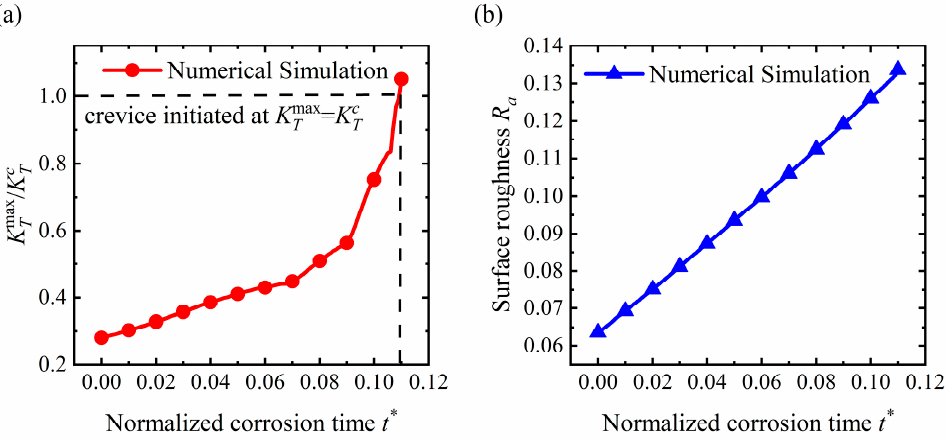
Figure 9. Evolution of ( a ) the maximal stress concentration factor and ( b ) surface roughness during corrosion when A ∗ = 0.1 and σ A = 100 MPa